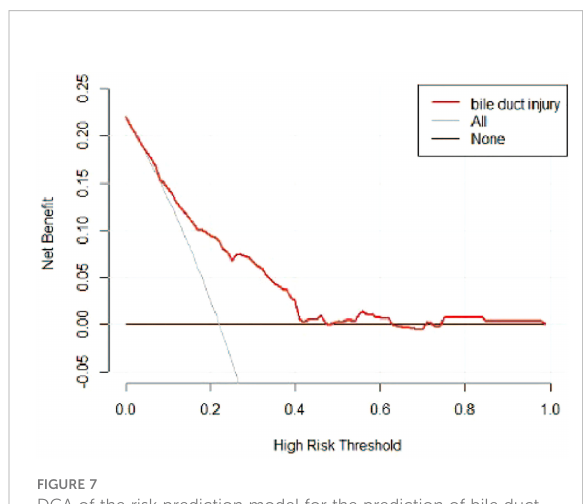
FIGURE 7 DCA of the risk prediction model for the prediction of bile duct injuries after DEB-TACE in patients with HCC. The horizontal line (i.e., the None line) represents that no patient had a bile duct injury, while the gray curve (i.e., the All line) represents all patients who had a bile duct injury.